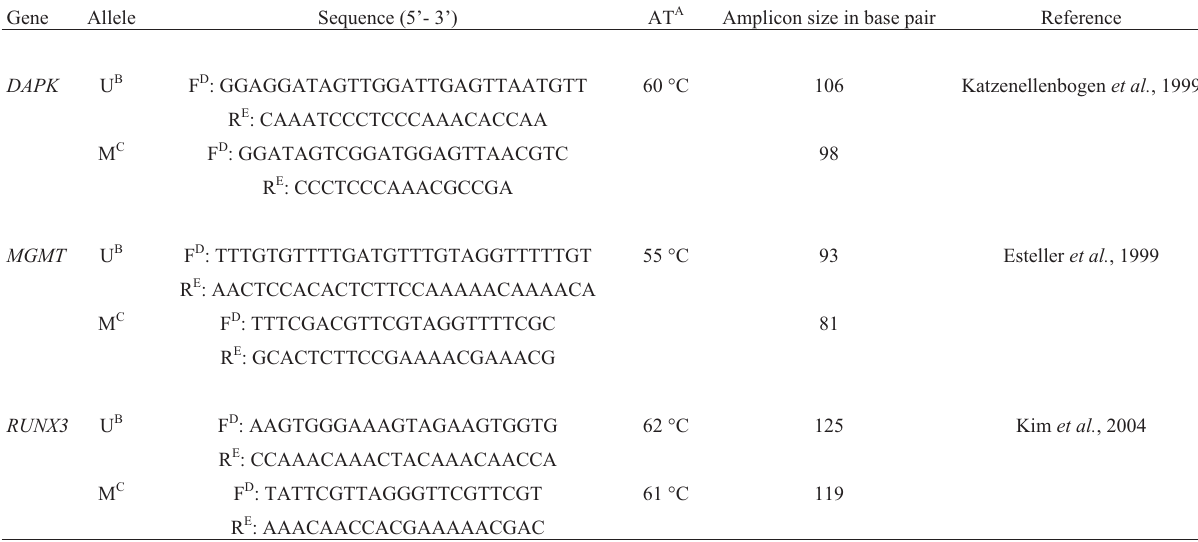
Table 1 - Primer sequences, annealing temperature and size of MS-PCR amplicons used for DAPK , MGMT and RUNX3 genes.